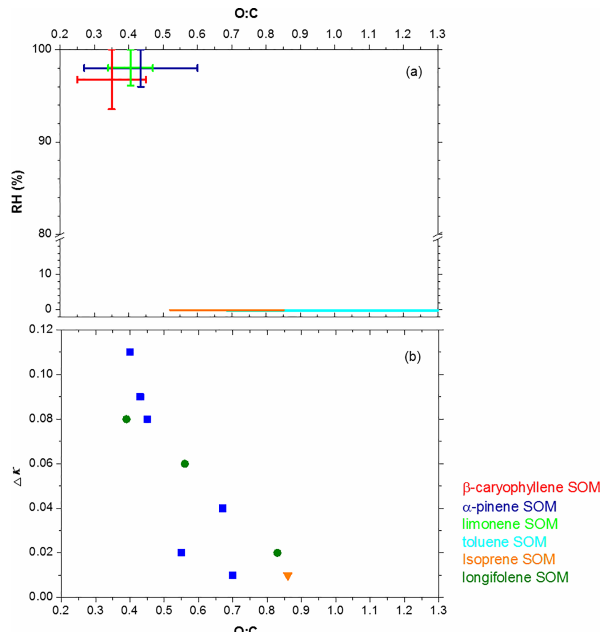
Figure 4. (a) Separation relative humidity (SRH) as a function of the average O:C of the organic material. Shown are the results from Table 3. β -Caryophyllene-derived SOM (red), limonene-derived SOM (light green), and toluene-derived SOM (cyan) from this study, isoprene-derived SOM (orange) from Rastak et al. (2017) and α -pinene-derived SOM (blue) from Renbaum-Wolff et al. (2016) as a function of O:C. RH value of 0% indicates that LLPS did not oc- cur. The O:C values of the SOM particles were taken from Table 3. (b) The difference between κ HGF and κ CCN , denoted as (cid:49)κ , as a function of the average O:C of the SOM. Data taken from Table 4. The experimental conditions for the studies reported in (a) were not necessarily similar to the experimental conditions for the studies re- ported in (b) , even if the same precursor volatile organic compound was